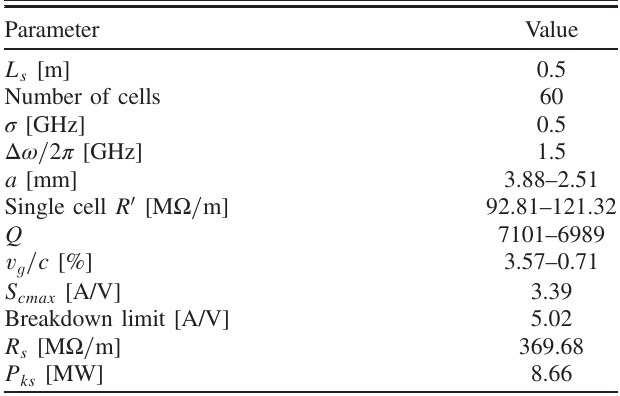
TABLE IV. Optimal overall parameters for the base design of an X -band linac for the XARA